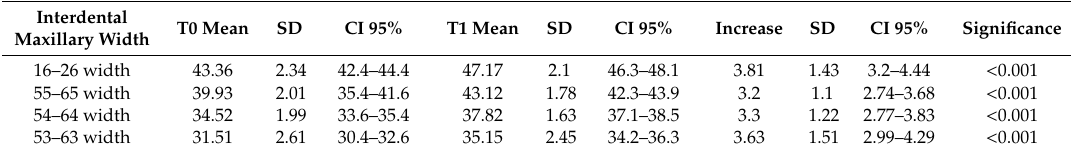
Table 4. Paired t -test comparing the mean interdental maxillary width (mm) increase after RME treatment—Control Group (n ◦ 21).